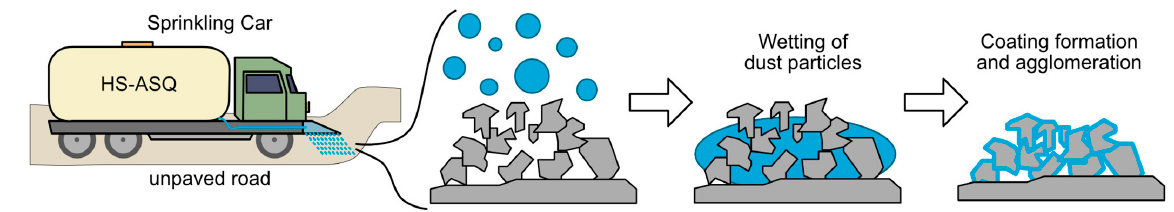
Figure 9. Scheme of the possible mechanism for disposing dust by HS–ASQ.